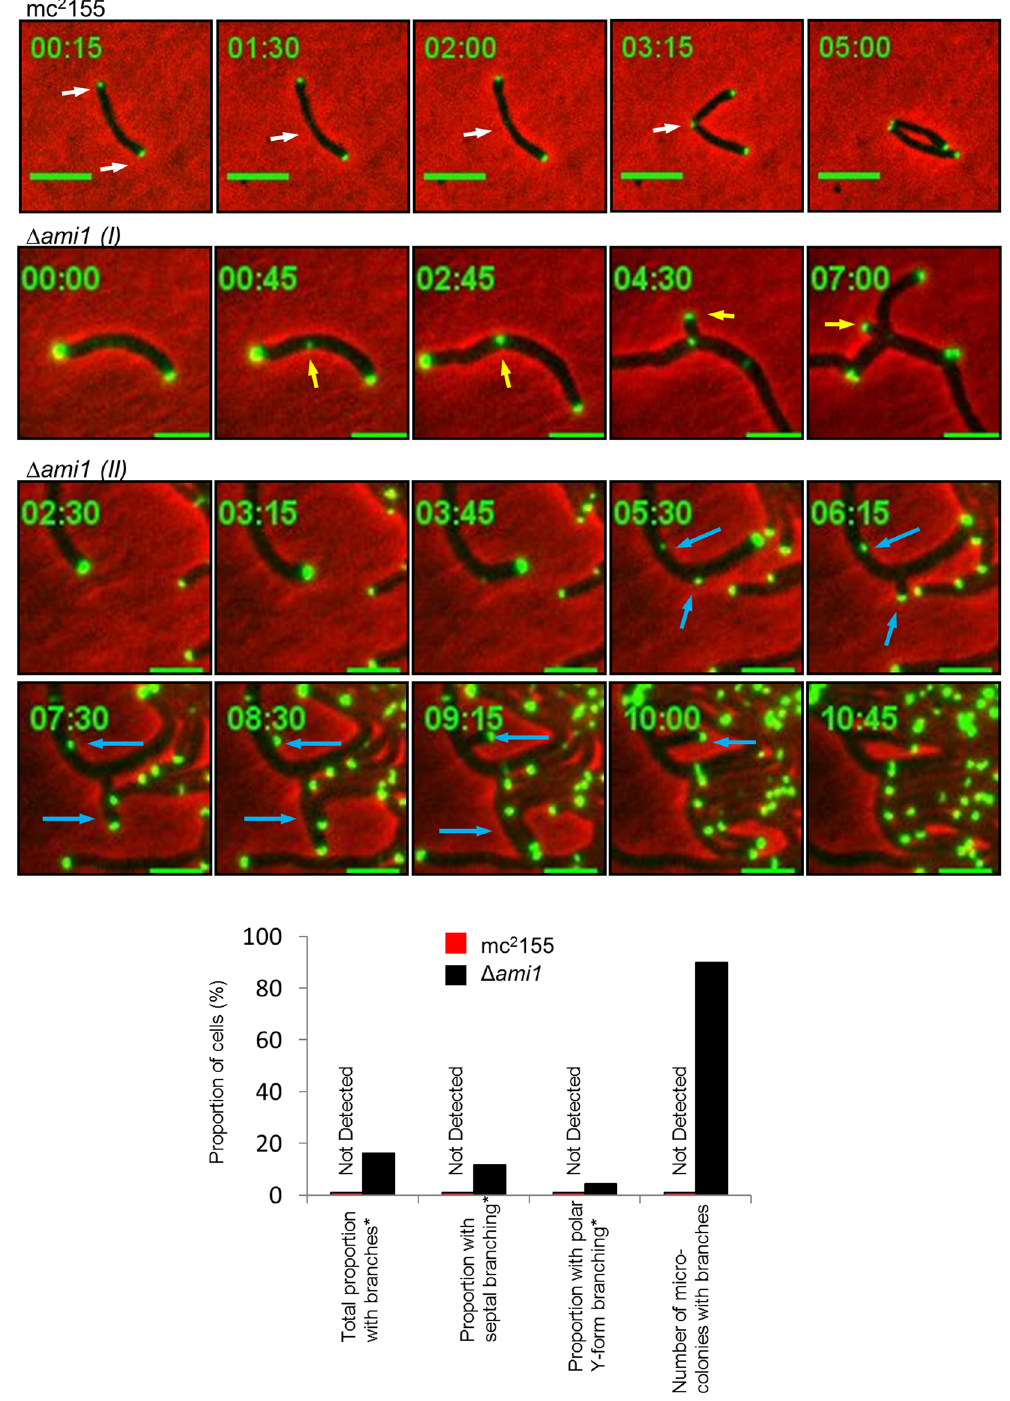
Figure 3. Time-lapse microscopic to assess the localization of DivIVA-rsEGFP. M. smegmatis mc 2 155 and Δ ami1 cells were grown in Middlebrook 7H9 and subjected to time-lapse analysis to monitor DivIVA localization, indicated by white arrows in the wild type. In the Δ ami mutant (panel I), DivIVA localizes at midcell, but the failure to separate leads to the formation of ectopic cell poles, which extend into lateral buds (yellow arrow). Alternatively, in the Δ ami mutant (panel II), DivIVA traffics to the lateral axis of the cell and nucleates lateral branching (blue arrows). Scale bar = 5 µ m. Time frame is in hours. The histogram depicts the proportion of cells with ectopic DivIVA localization. For the Δ ami1 mutant and wild type, 1404 and 1626 individual cells were assessed. * The assessment of the proportion of cells with branches is subject to underestimation as cellular crowding makes accurate quantification difficult. Reported here is the proportion of cells with clearly visible branching